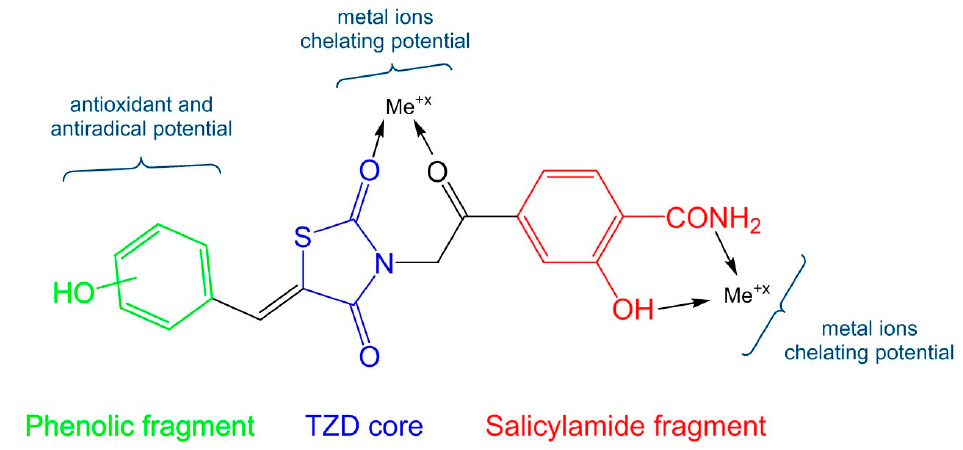
Figure 1. The hypothesis for designing the new compounds.